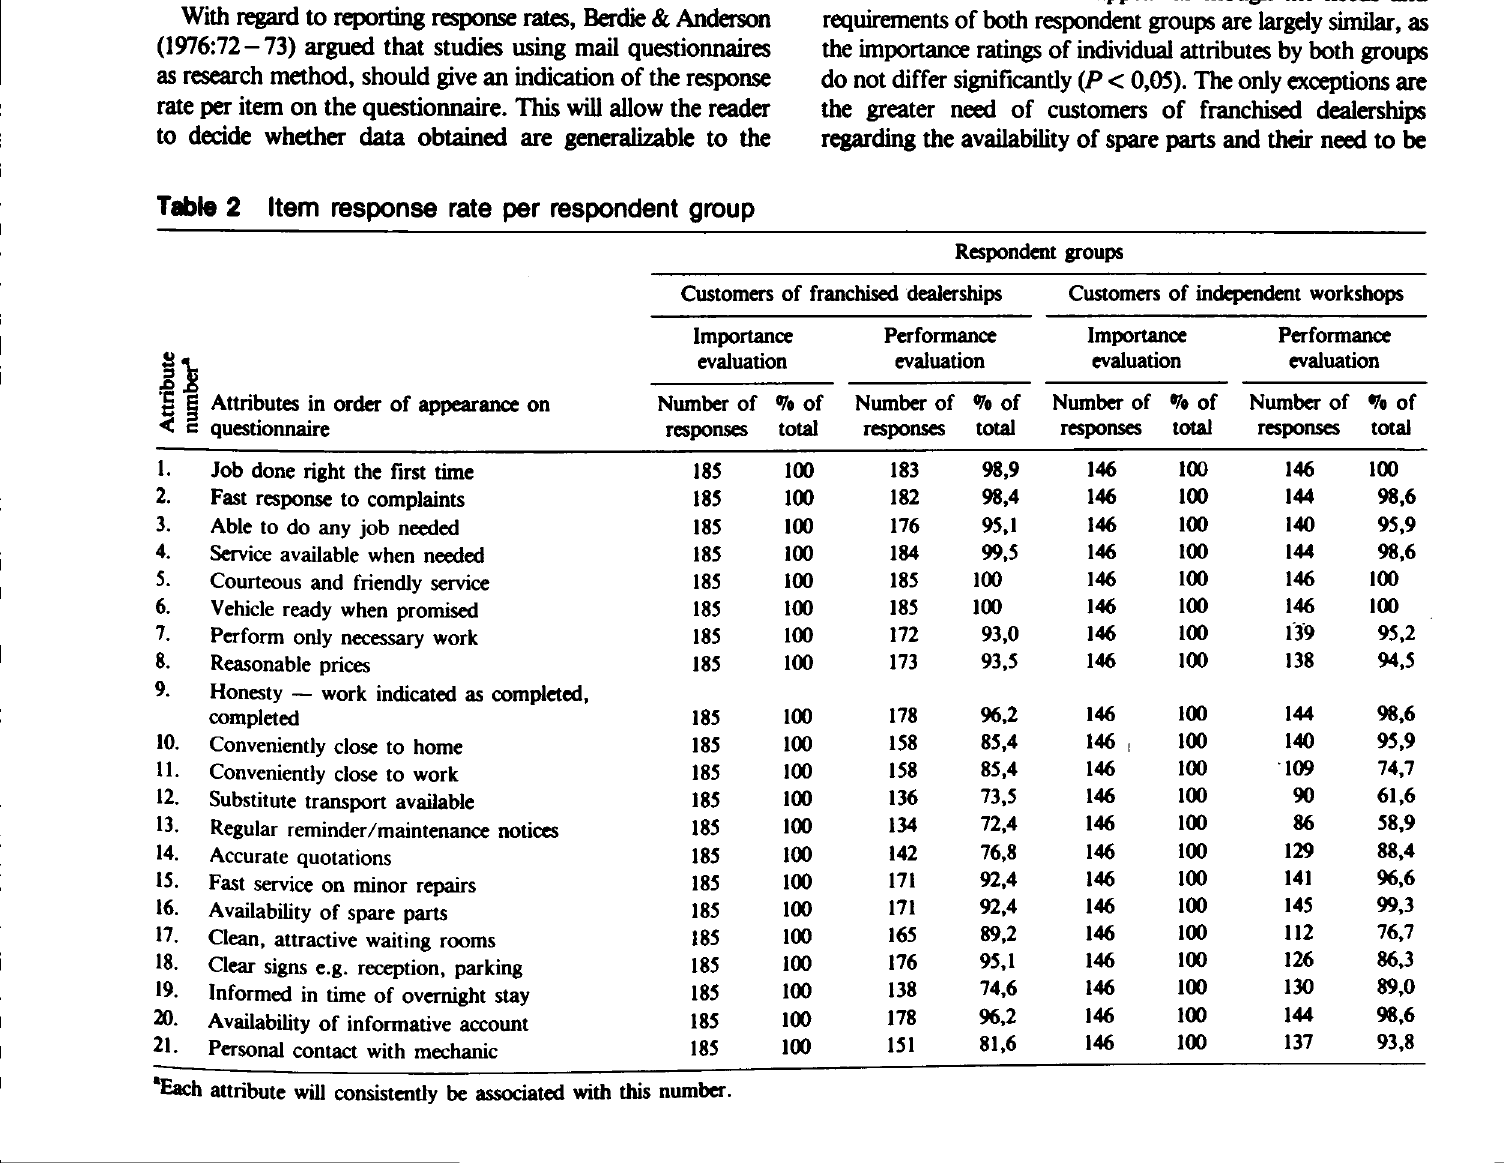
Item response rate per respondent